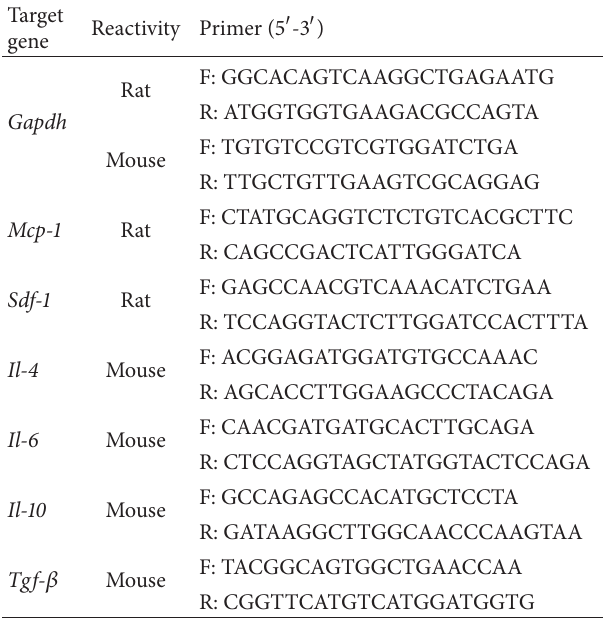
Table 1: Primer sequences for